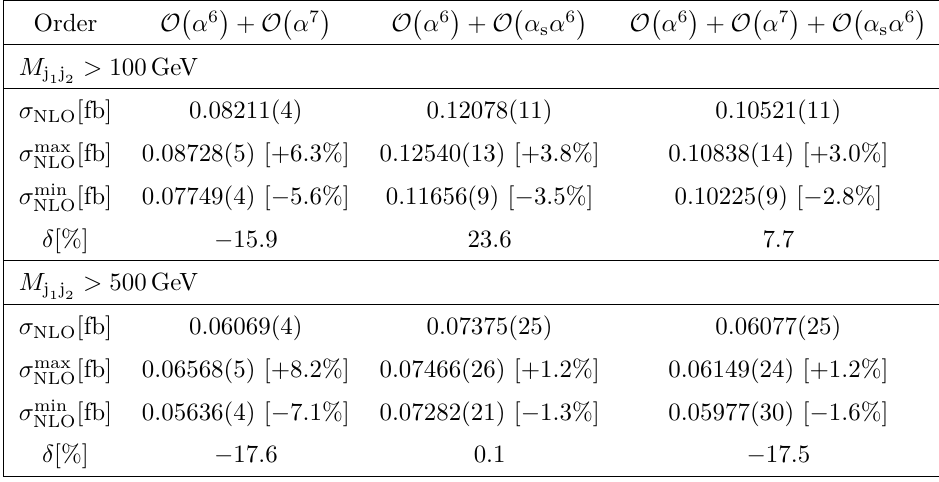
Table 2. Fiducial cross sections for pp → e + e − µ + µ − jj + X at 13 TeV CM energy at NLO EW (cid:0) (cid:1) (cid:0) (cid:1) (cid:0) (cid:1) (cid:0) (cid:1) [ O α 6 + O α 7 ], NLO QCD [ O α 6 + O α s α 6 ], and NLO QCD+EW [ O Each contribution is given in fb (with the extrema resulting from scale variations as absolute numbers and as deviation in percent) and as relative correction δ = σ NLO /σ While the numbers in the upper part of the table are for the inclusive setup, those in the lower part are for the VBS setup. The digits in parentheses indicate the integration